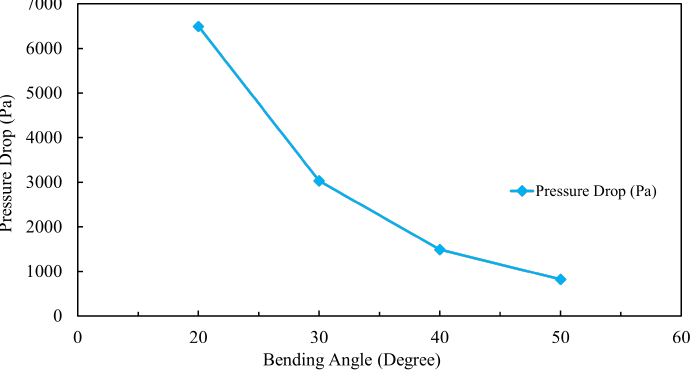
Figure 12. Pressure drop between the inlet and orifice outlet for various bending